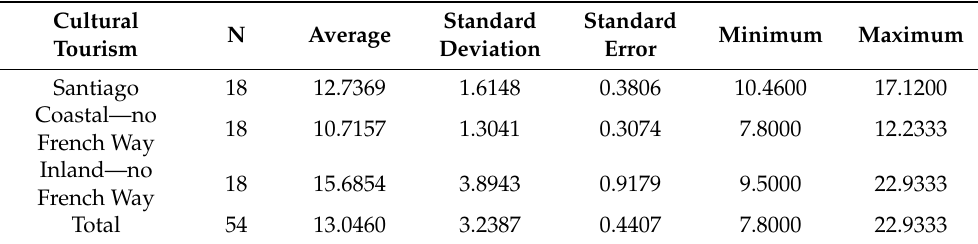
Table 3. Descriptive statistics of the ACs of the French Way and the coastal and inland regions through which the French Way does not pass.